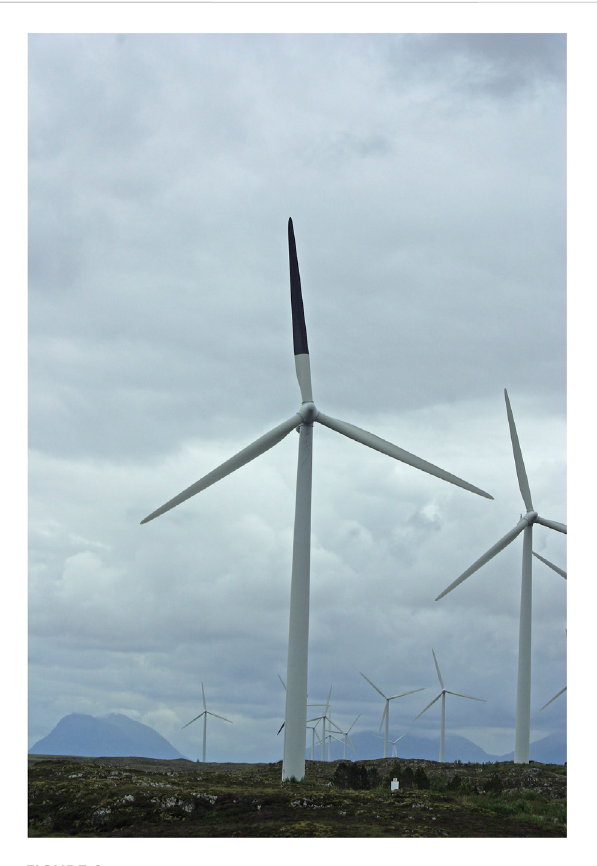
FIGURE 2 A wind turbine in the Smøla wind-power plant with one rotor blade painted black. © Roel